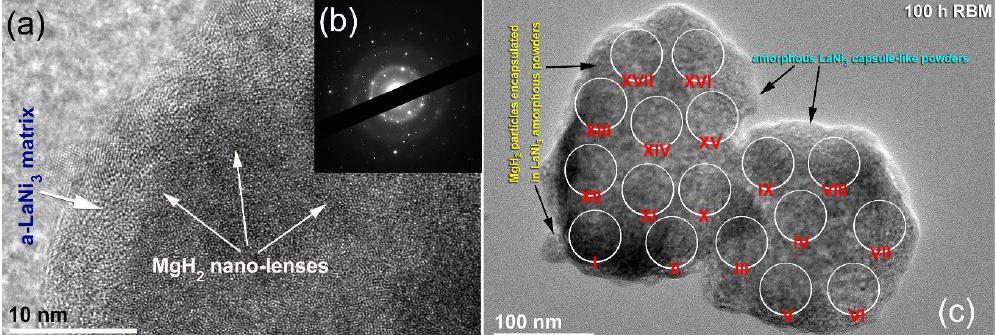
Figure 7. ( a ) FE-HRTEM image and ( b ) SADP of nanocomposite MgH 2 /7 wt% a-LaNi 3 powders obtained after 100 h of rod milling. The BFI of powders obtained after 100 h of rod milling, undertaken for EDS elemental analysis is presented in ( c ), where the analysis are listed in Table 1. Table 1. Elemental Analysis Corresponding to the Indexed Zones Shown in Figure 8. Content (wt%) Zone Mg LaNi 3